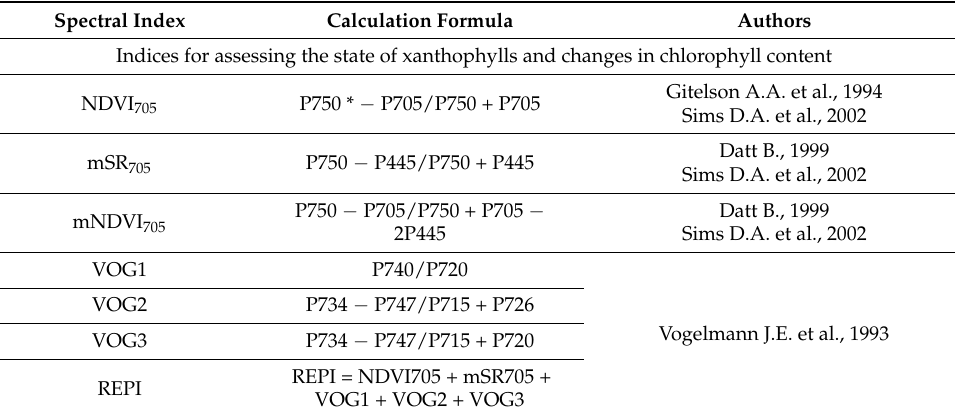
Table 2. Description of the sample of vegetation indices for assessing the vegetation parameters of plant